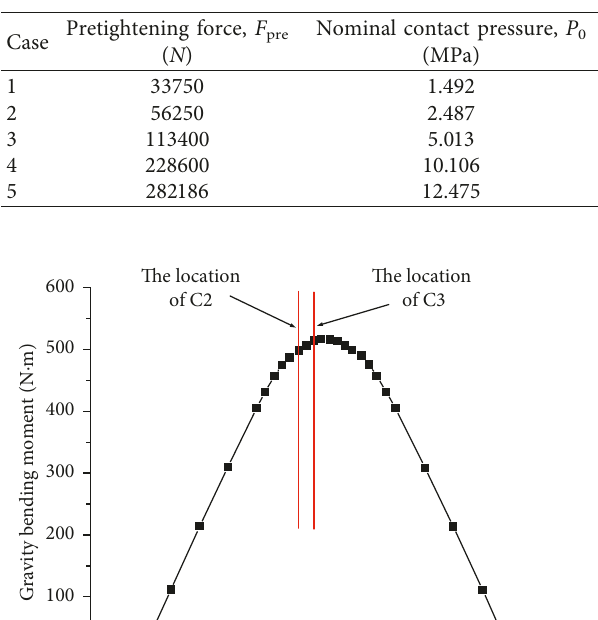
Figure 10: Effect of the length of the contact segment on η Table 2: Different pretightening forces applied on the tie rod set 2 and tie rod set 3.